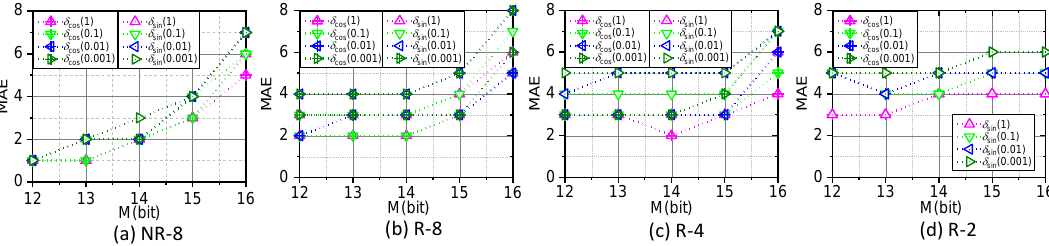
Figure 6. The relations between maximum absolute errors (MAEs) and the input bit width M of the NR-8, R-8, R-4 and R-2 CORDIC algorithms. The angles θ change from 0 to 90° in steps of 1, 0.1, 0.01 and 0.001°.